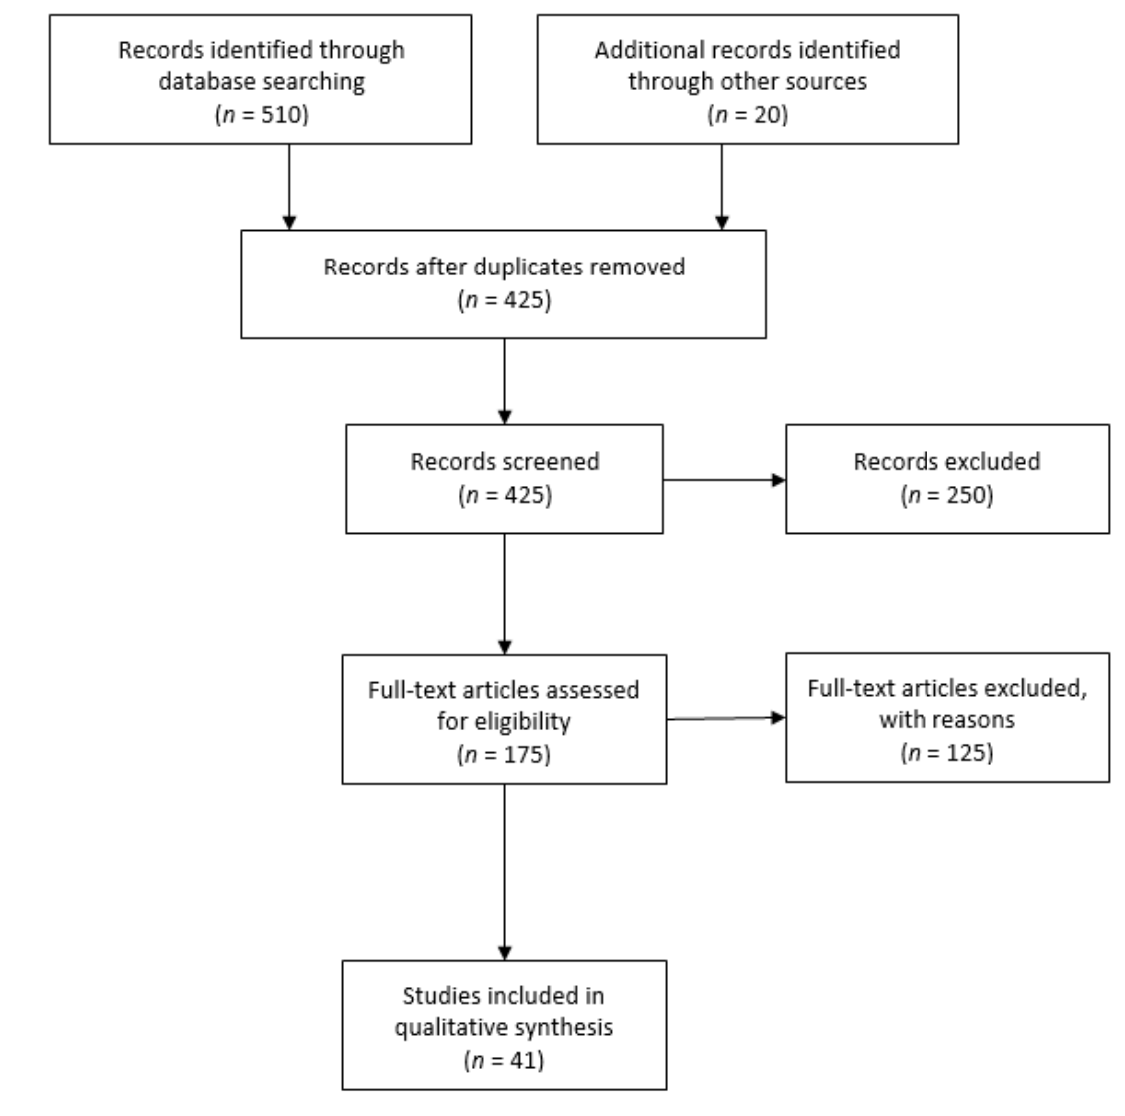
Figure 1. Preferred reporting items for systematic reviews and meta-analyses (PRISMA 2009) flowchart